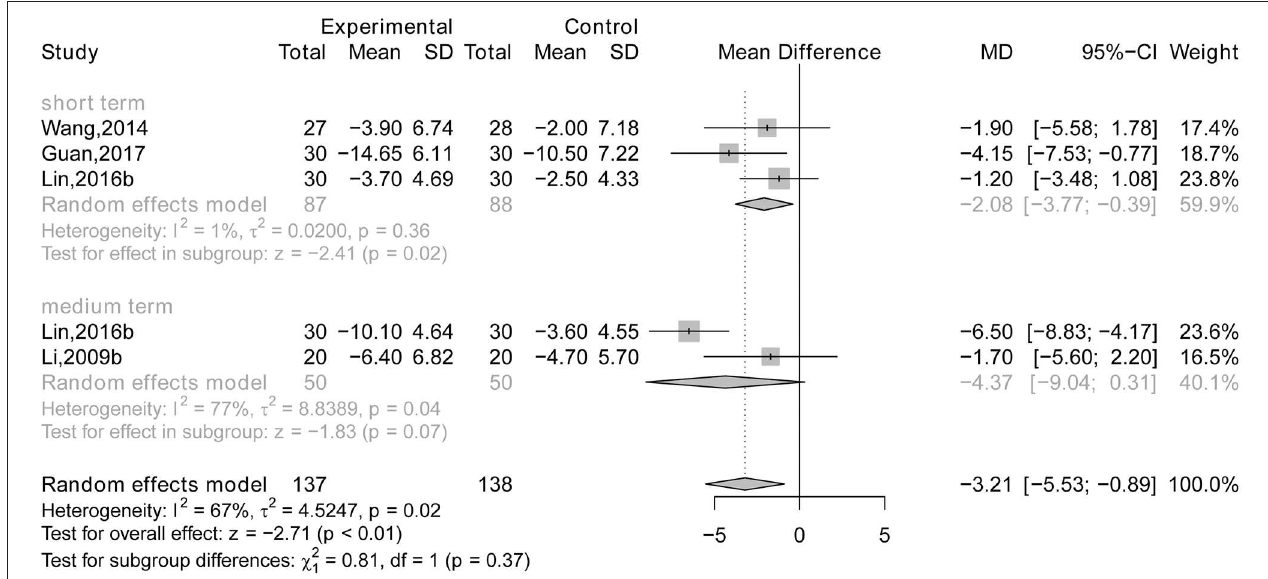
FIGURE 8 | The forest plot of ADAS-cog of acupuncture plus drug therapy vs. drug therapy alone. Lin (2016b), acupuncture plus Donepezil vs. Donepezil; Li (2009b), acupuncture plus Yizhijiannao vs. Yizhijiannao.